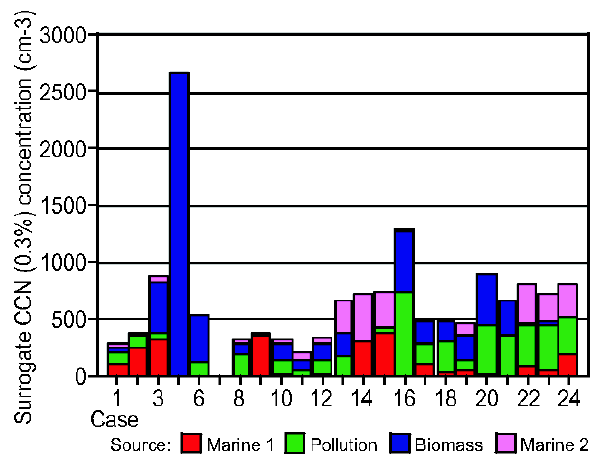
Fig. 6. Source contributions to the surrogate CCN (0.3%) concen- tration of each of the three sources to each sample taken during the CARMA III study. The samples shown were taken consecutively between 6 and 26 August